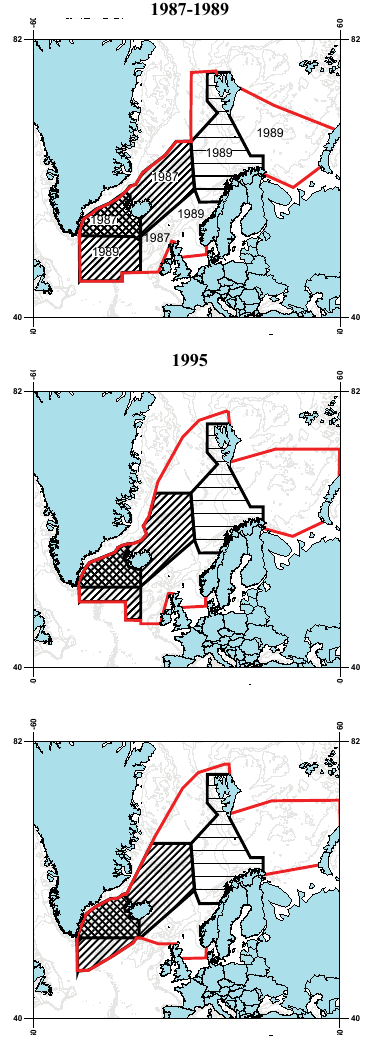
Fig. 3. Regions used in examining trends in fin whale abundance. Survey year is indicated for the 1987-1989 compilation. The Norwegian sector of the 2001 survey was surveyed in the period 1996-2001. Cross hatched – WEST; Diagonally hatched – EGI; Horizontally hatched – NORWAY; TOTAL outlined in